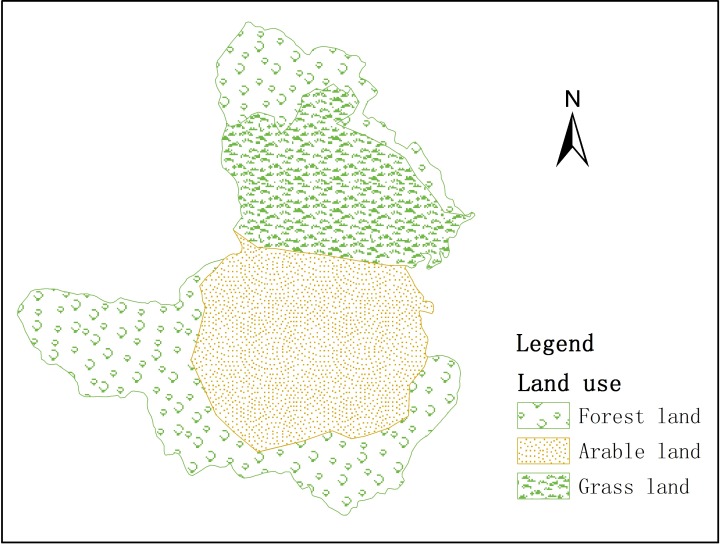
Land uses in Gujiao.